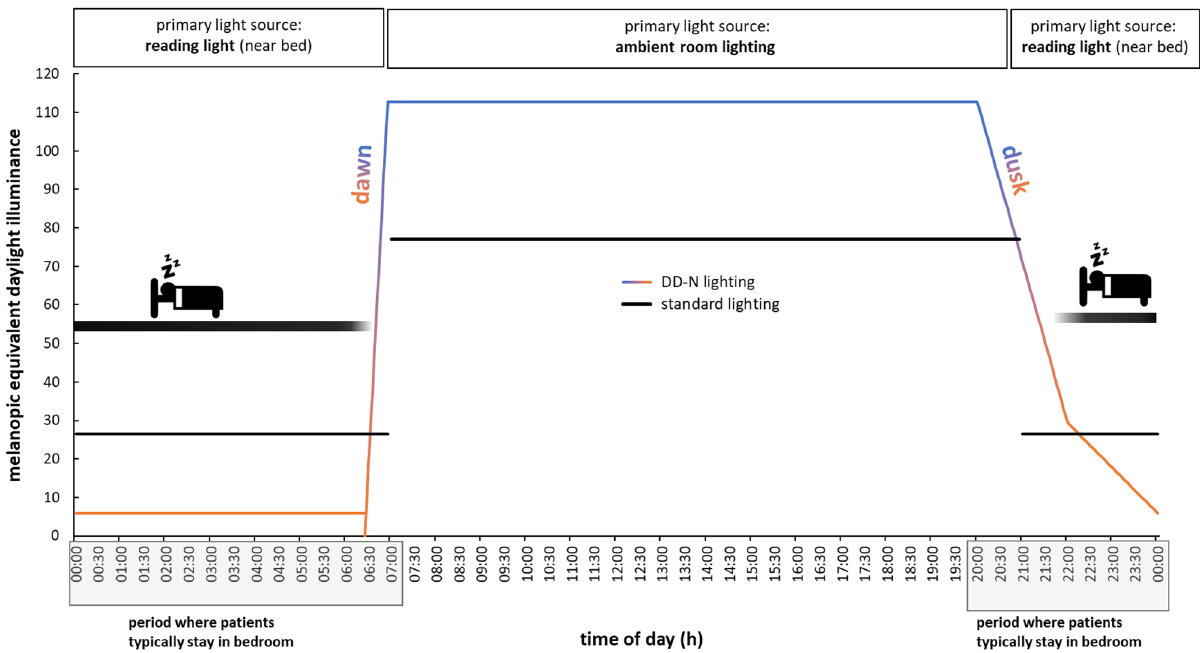
Figure 2. Light control strategies. Nighttime (00:00 h–06:25 h) and daytime (07:00–20:00 h) melanopic daylight-equivalent illuminances were reduced by 78% and increased by 46% under DD-N lighting compared to standard bedroom lighting, respectively. The lighting control system actually changed the light intensity and light color during dawn and dusk linearly over time (dawn: 6:25–07:00 h; dusk: 20:00–00:00